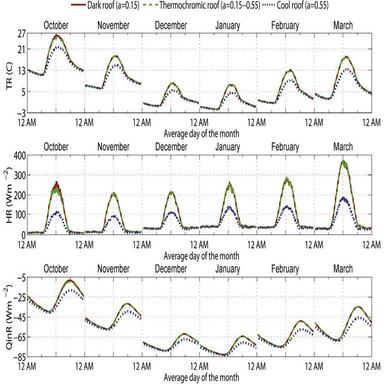
Dark (α = 0.15), thermochromic (α = − 0.15 0.55) and cool (α = 0.55) external roof surface temperature (TR), outward sensible heat flux (HR) and inward heat flux (QinR) monthly-averaged diurnal cycles for the six autumn and winter months.